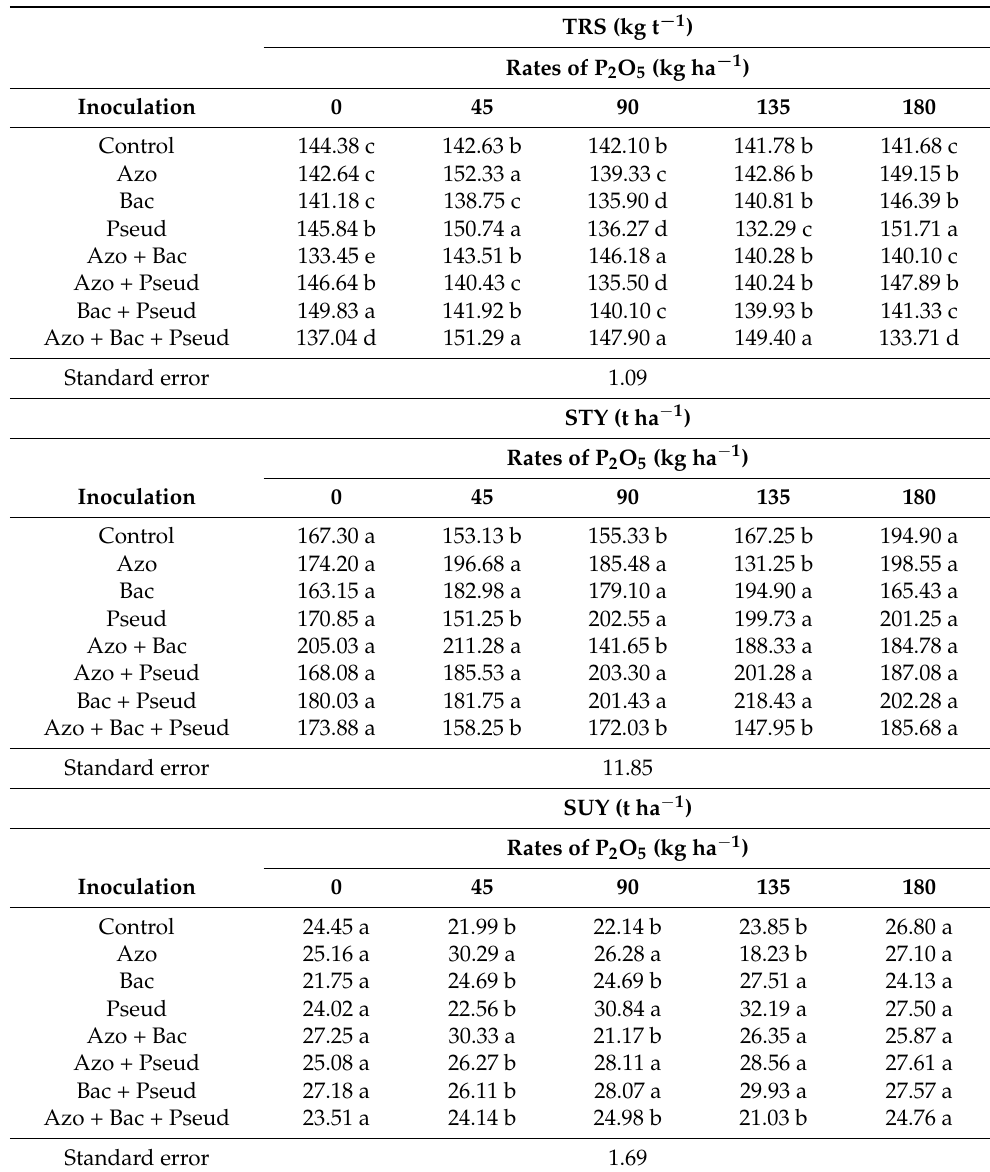
Table 5. Interaction of inoculation and P 2 O 5 rates for total recoverable sugar (TRS), stalk yield (STY) and sugar yield (SUY) of RB92579 sugarcane